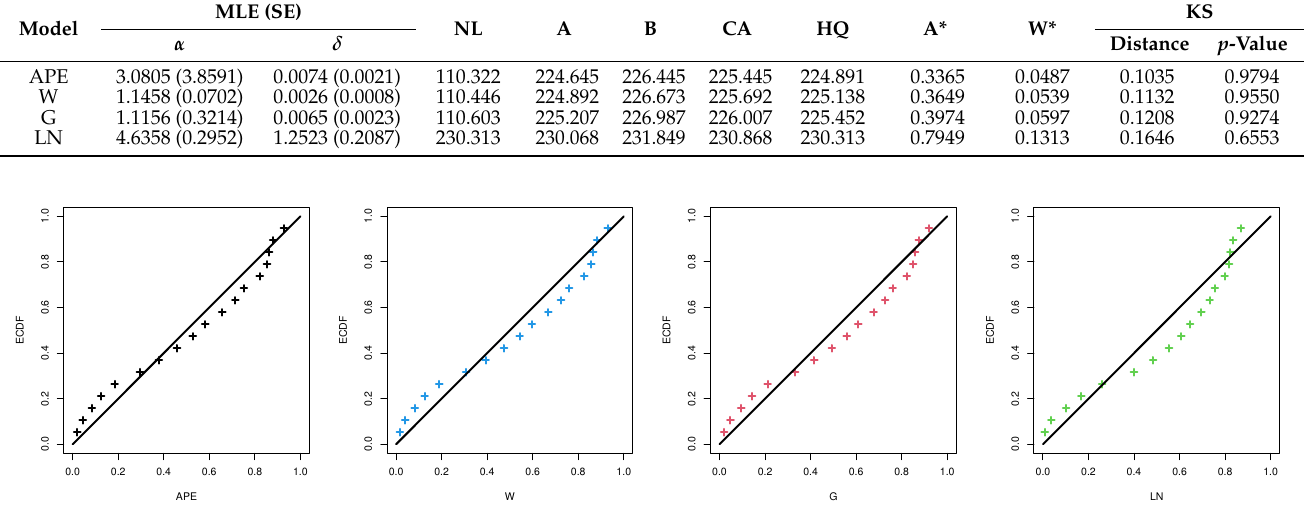
Figure 9. The quantile–quantile plot of the APE distribution and other competing models from electronic devices data.